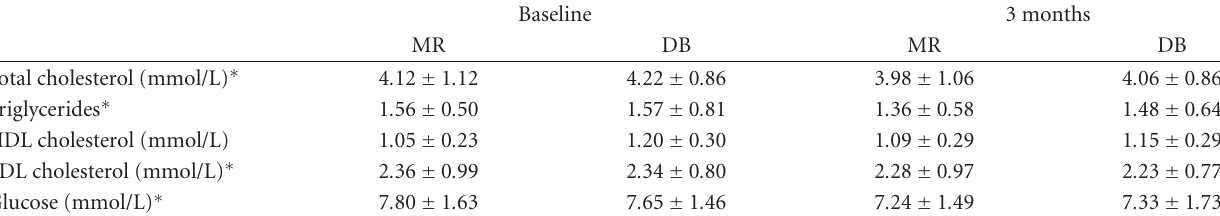
Table 6: Lipids and glucose at baseline and 3 months.